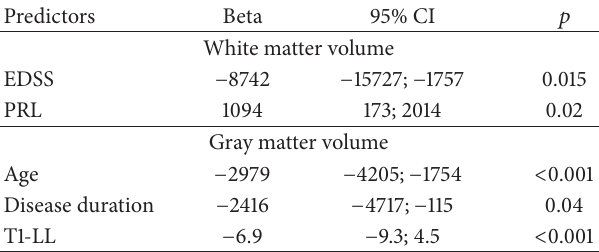
Table 2: Significant predictors of WM volume and GM